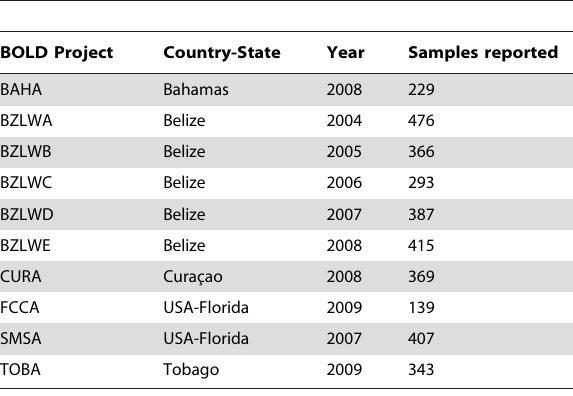
Table 1. Collection efforts (by BOLD project) resulting in specimens reported here.